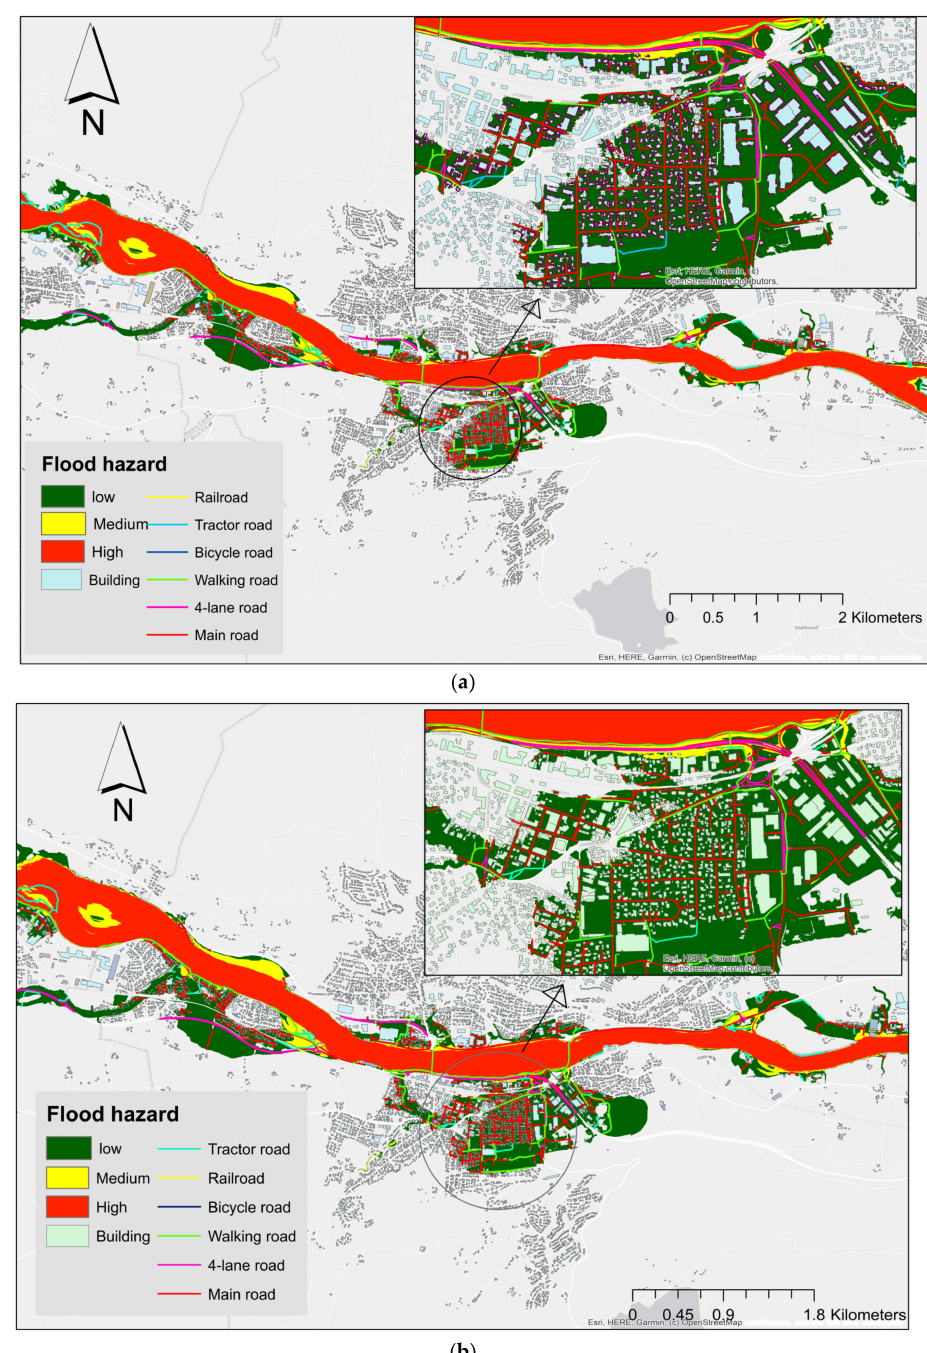
Figure 4. Flood intensity in the model area for the flood scenario: ( a ), Q200 for current climate, and ( b ) Q200 for future